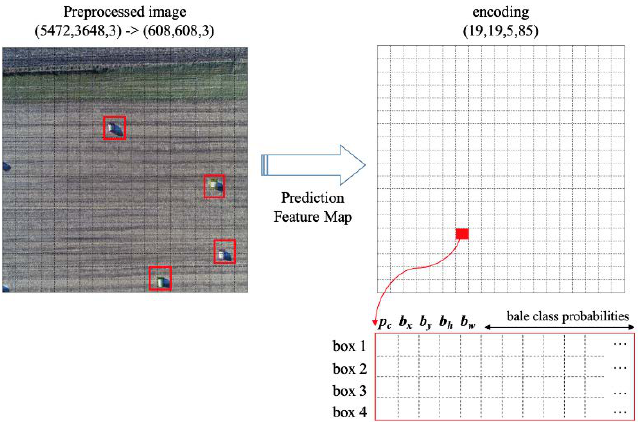
Figure 3. Explanation of encoding in the YOLOv3 architecture.